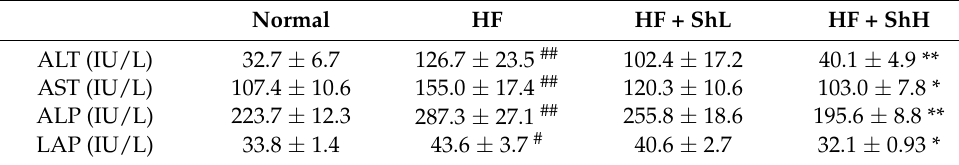
Figure 5. Effects of S. horneri on the hepatic lipid accumulation in C57BL/6J mice fed a high-fat diet for 13 weeks. ( a ) Liver weight; ( b ) liver triglyceride content; ( c ) representative gross morphology, and histological sections of the liver. Normal, normal diet; HF, high-fat diet; HF + ShL, high-fat diet mixed with 2% S horneri ; HF + ShH, high-fat diet mixed with 6% S. horneri . Each value represents the mean ± SEM ( n = 8). Significant difference: * p < 0.05, ** p < 0.01 vs. HF group, ## p < 0.01 vs. Normal group. Table 3. Effects of S. horneri on the serum parameters of the liver